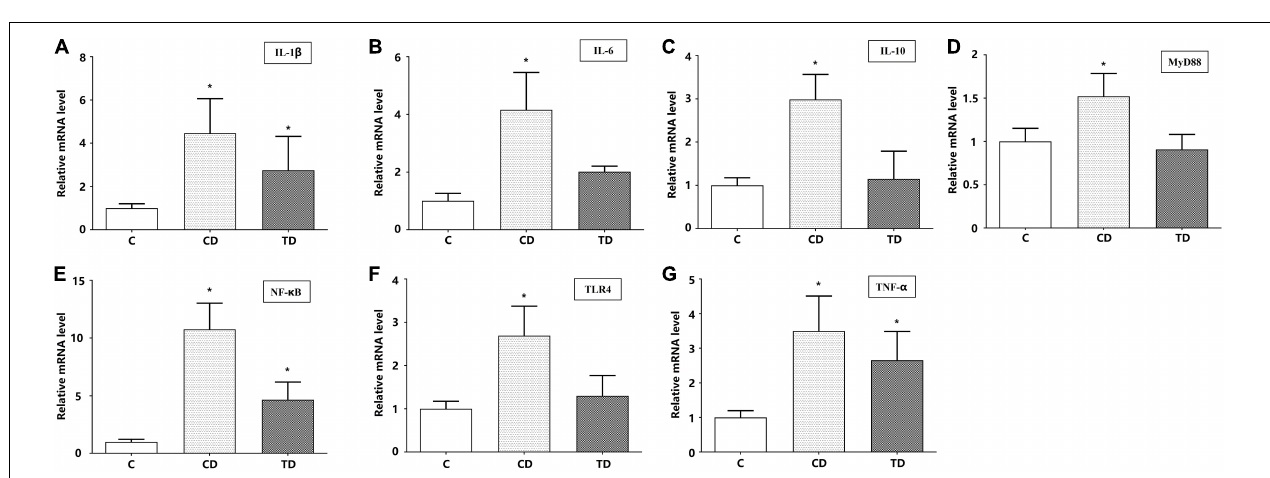
FIGURE 7 | Kyoto Encyclopedia of Genes and Genomes (KEGG) pathway analysis. Clustered heatmap of the KEGG genes and pathways for CD vs . C (A) and TD vs . CD (B) . Color bars over the pathway names represent the combined scores ( p -values and z -scores) of the pathways. TD , Tibetan tea + DSS; CD , dextran sodium sulfate-induced model; C ,